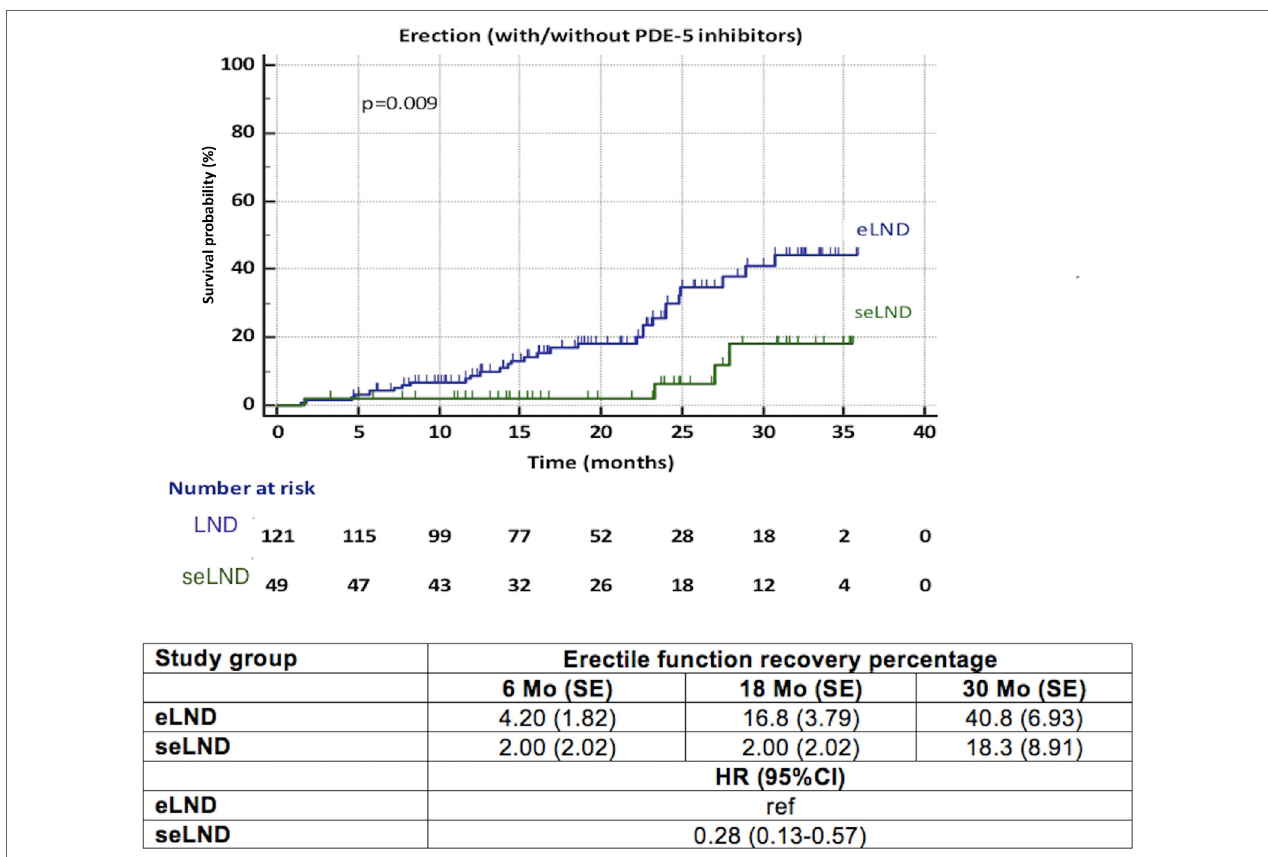
FigUre 3 | Recovery of erectile function after radical prostatectomy among patients with extended lymph node dissection (eLND) versus super-extended lymph node dissection (seLND) during surgery. HR, hazard ratio, Mo, months, CI, confidence interval, ref, reference, SE, standard